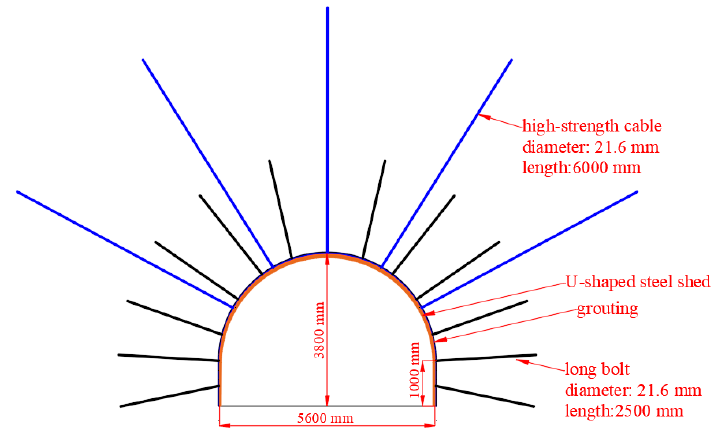
Figure 16. Schematic presentation of proposed solutions.